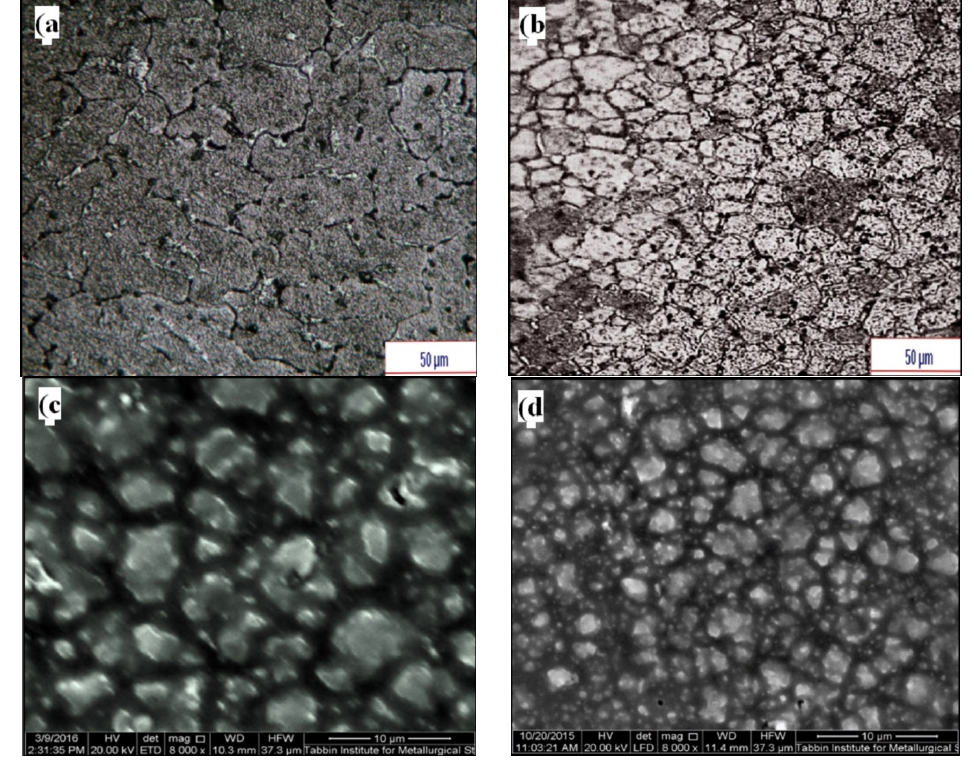
Figure 3. Microstructure of as-received ( a ) extrusion temperature (ET) = 500 °C; ( b ) ECAP-2; ( c ) ECAP-4; and ( d ) ECAP-6. Table 4. Effect of ECAP process on solid-state recycled aluminum Alloy 6061 chips after extrusion (500 °C).